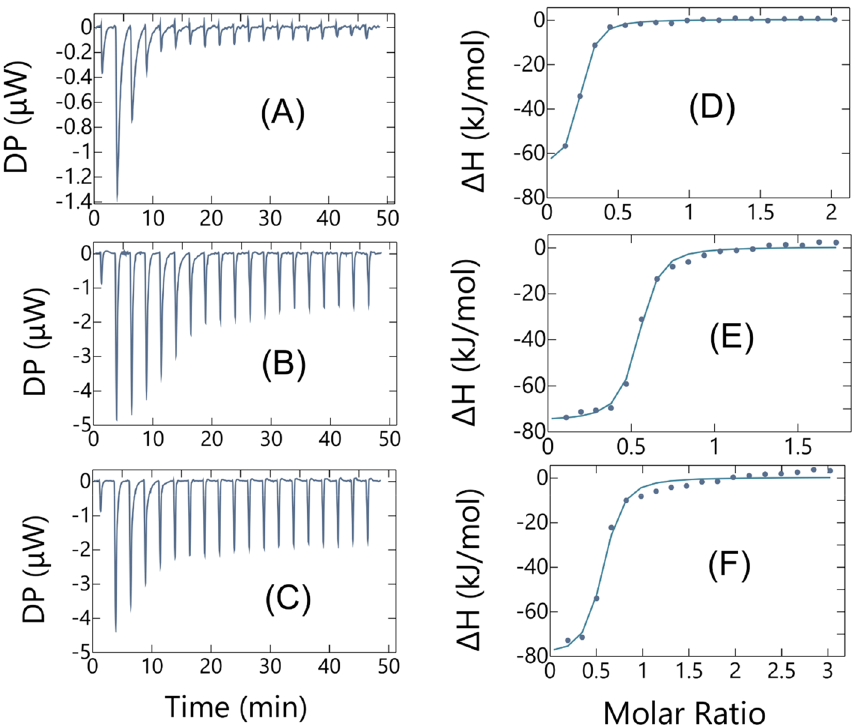
Figure 2. Isothermal calorimetric titration of FliC-ArsR variants with PAO at 25 °C. FliC-ArsR samples (c ~ 50 µM) were loaded into the cell and PAO (c ~ 0.5 mM) solution was injected in 2 μL portions. Titrations were performed in 100 mM HEPES (4-(2-hydroxyethyl)-1-piperazineethanesulfonic acid), 150 mM NaCl, 1 mM TCEP (pH 7.0) buffer. Beside the raw titration curves, changes in binding enthalpy ( ▪ ) of the injections are shown as a function of the molar PAO to FliC-ArsR ratio. The solid line is the least-squares fit to the data by using a one-binding-site model, resulting in the following parameters: ( A , D ) for FliC-ArsR9, stoichiometry N = 0.2, dissociation constant K d = 6.9·10 −7 M, binding enthalpy ΔH = − 68.2 kJ/mol, ( B , E ) for FliC-ArsR10, N = 0.5, K d = 3.7·10 −7 M, ΔH = − 76.2 kJ/mol, ( C , F ) for FliC-ArsR6, N = 0.5, K d = 6.3·10 −7 M, ΔH = − 81.0